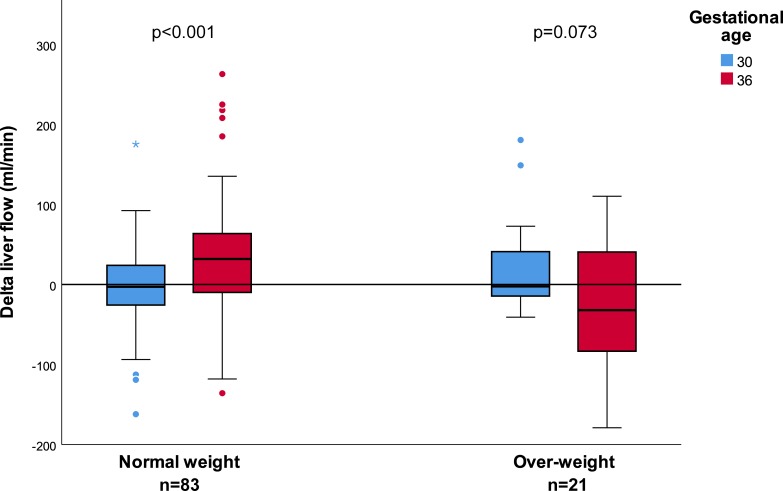
Change in fetal liver blood flow in gestational weeks 30 and 36, between two maternal weight groups.Box-plot shows the Δliver blood flow at 30 (blue) and 36 (red) weeks gestation stratified by maternal weight (median values): the normal-weight group (ppBMIa 18.5–25.0 kg/m2, n = 83) and the overweight group (ppBMI >25.0 kg/m2, n = 21). In week 36, the Δliver flow was significantly different between the two maternal groups (p = 0.006), but not in week 30 (p = 0.155).